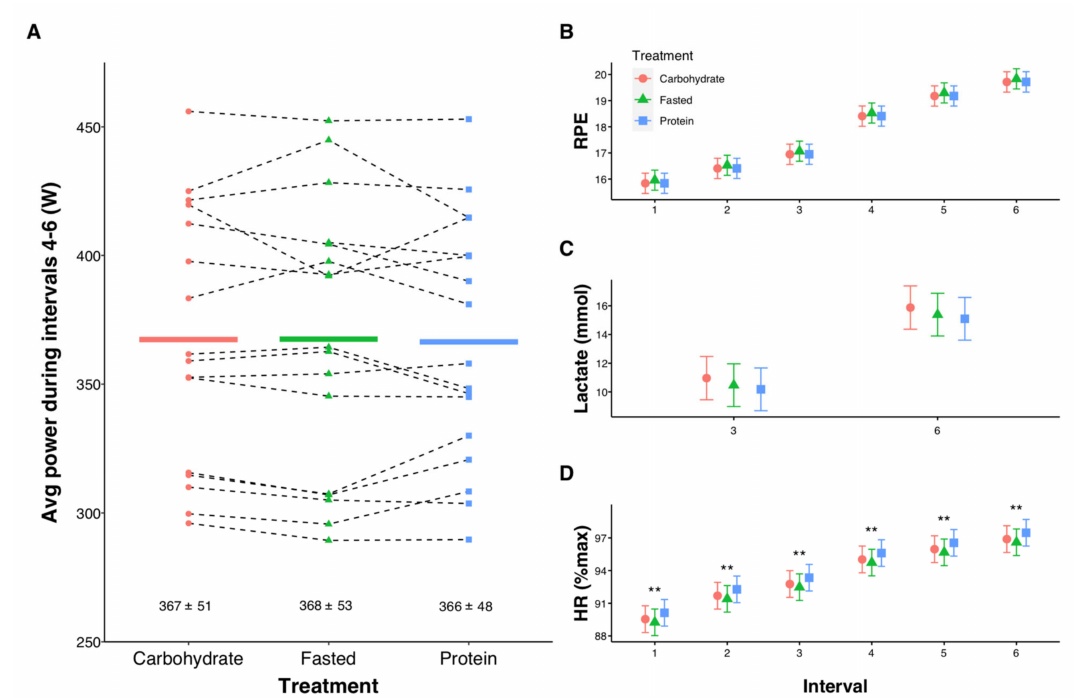
Figure 4. Influence of pre-exercise nutrition interventions on mean power during three all-out 3-min efforts ( A ), rating of perceived exertion (RPE, B ), lactate ( C ), and heart rate (HR, D ) during high-intensity interval training. In ( A ) individual data points are shown with solid lines representing means and numeric values reflecting mean ± SD. In ( B – D ), error bars represent 95% confidence intervals of the model-estimated mean. ** Significant differences for FASTED vs. PROTEIN ( p <